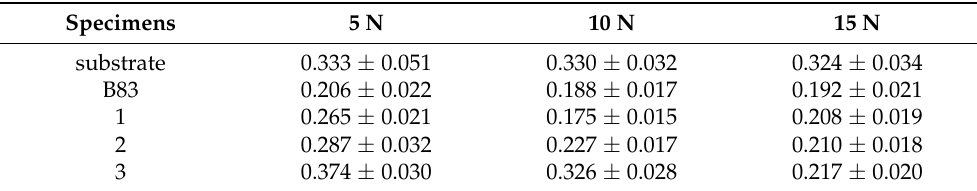
Table 6. The friction coefficients during the substrate, Babbitt B83, and running-in coating tests at loads of 5 N, 10 N, and 15 N.